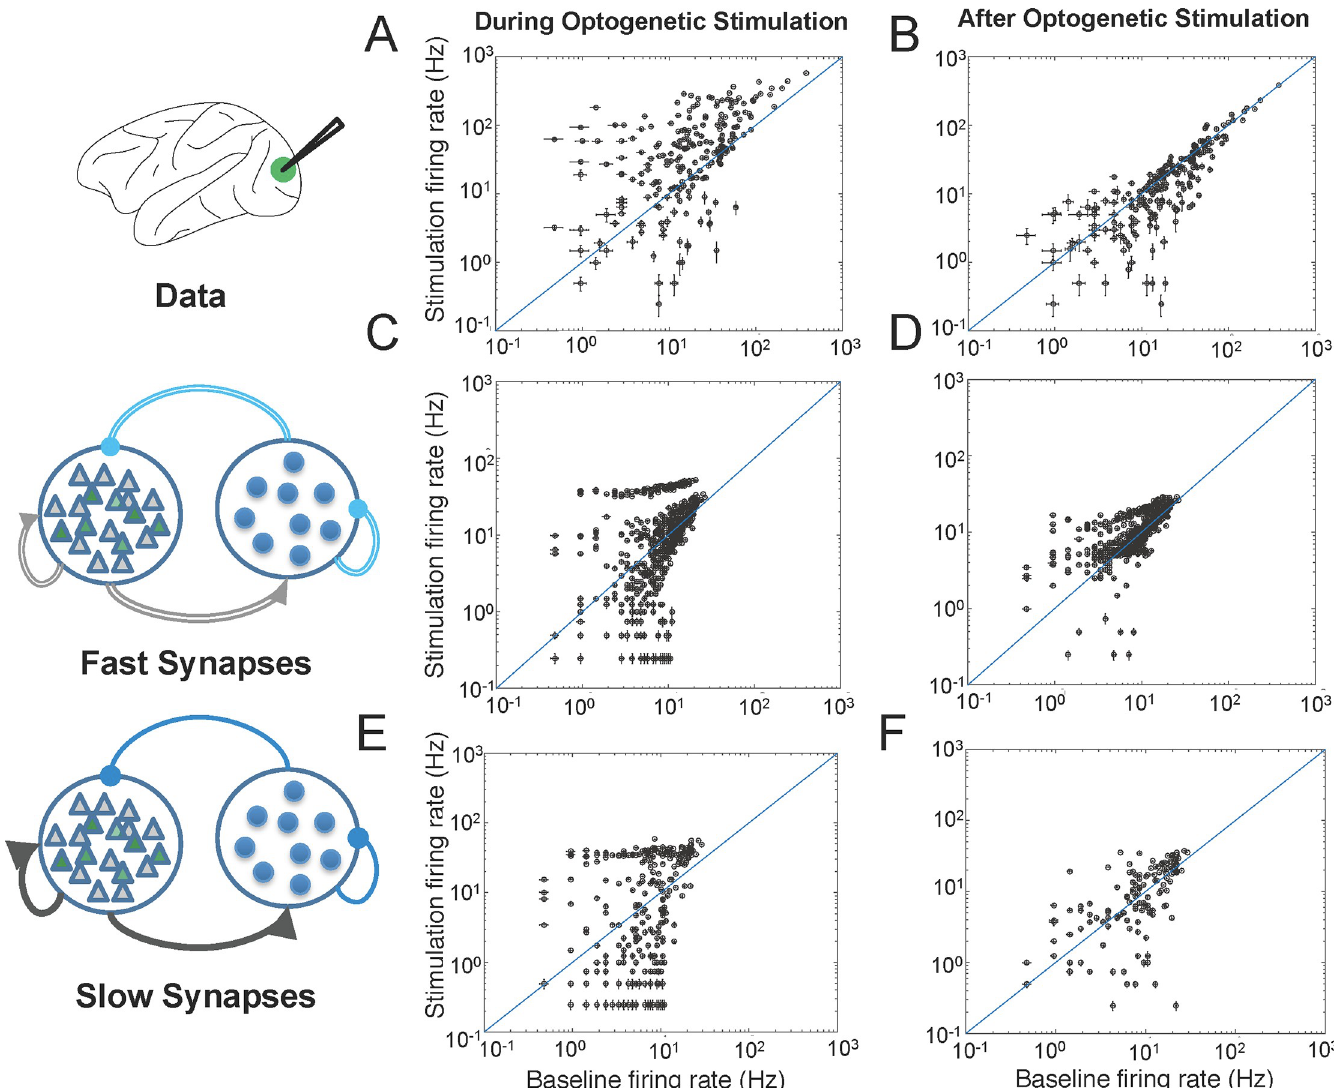
Fig 2. Modeling changes in mean responses. A,B) Mean responses from the data and simulation during optogenetic stimulation (Fig 2A; 0-200ms following laser onset) and immediately following stimulation (Fig 2B; 10–210 milliseconds following laser offset). (top) From the macaque data, a total of 249 units were recorded from two animals (142 from Monkey A, 107 from monkey M). Of these, 137 units were facilitated (55 single units, and 82 multi-units) and 23 units were suppressed (22 single units, 1 multi-unit) during optogenetic stimulation. Of these 160 units, 62 (42 single units, 20 multi-units) were also suppressed for the 10–210 milliseconds following laser offset (right). B-E) We developed two models, one that included fast excitatory and inhibitory synapses with τ c = 5–10 ms, and one that included slow synapses, with τ c = 100–200 ms. We tuned these models to capture the mixture of facilitative and suppressive effects seen during optogenetic stimulation as well as the suppressive effect across the population seen following optogenetic stimulation.